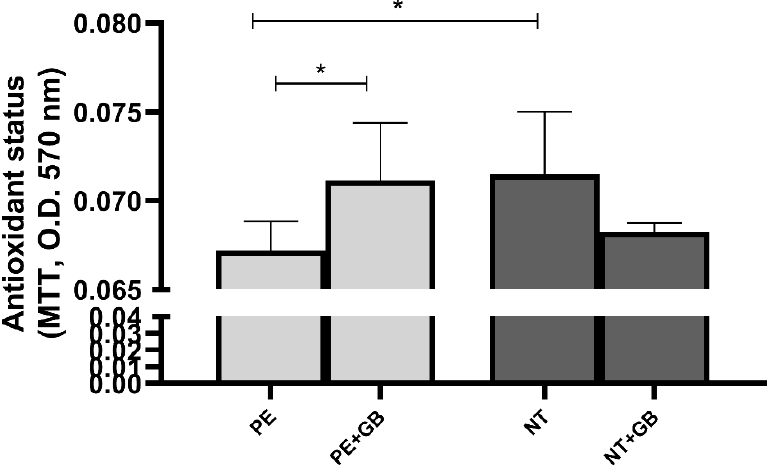
Figure 7. MTT reduction in the supernatant of HUVEC culture with plasma and GB. Three independent experiments with replicates of 5 per group in each experiment. Data are presented as mean ± SEM. (ANOVA) followed by Tukey’s test. * ( p < 0.05).